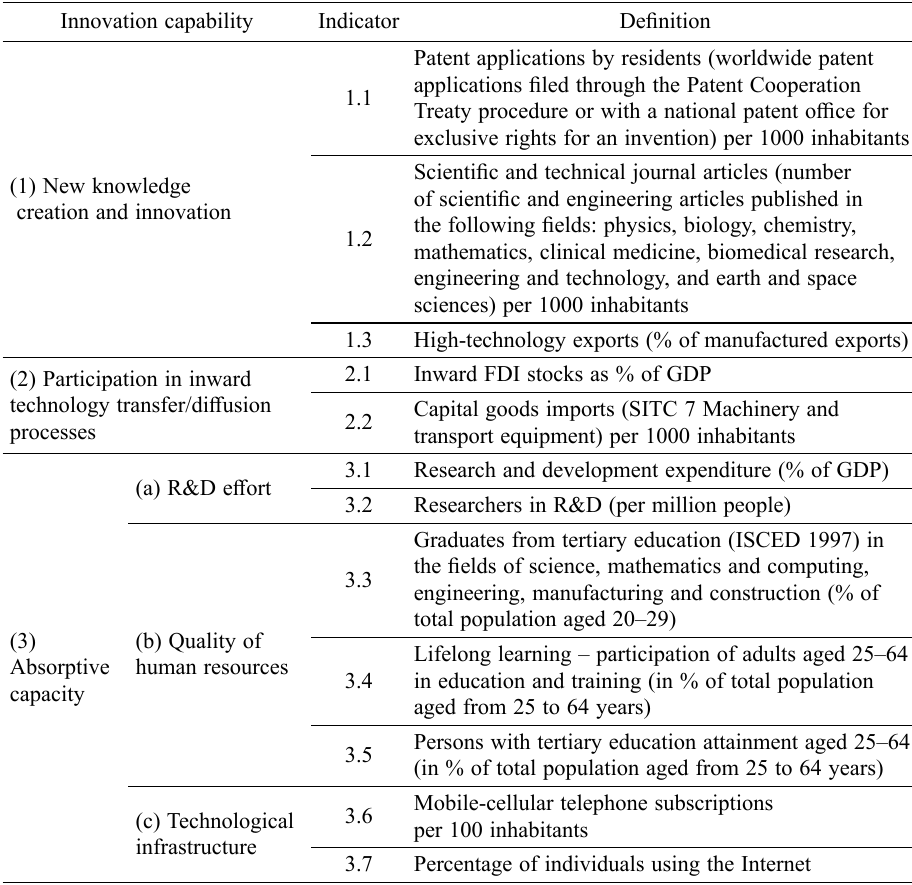
Table 1. Proposed measures of innovation